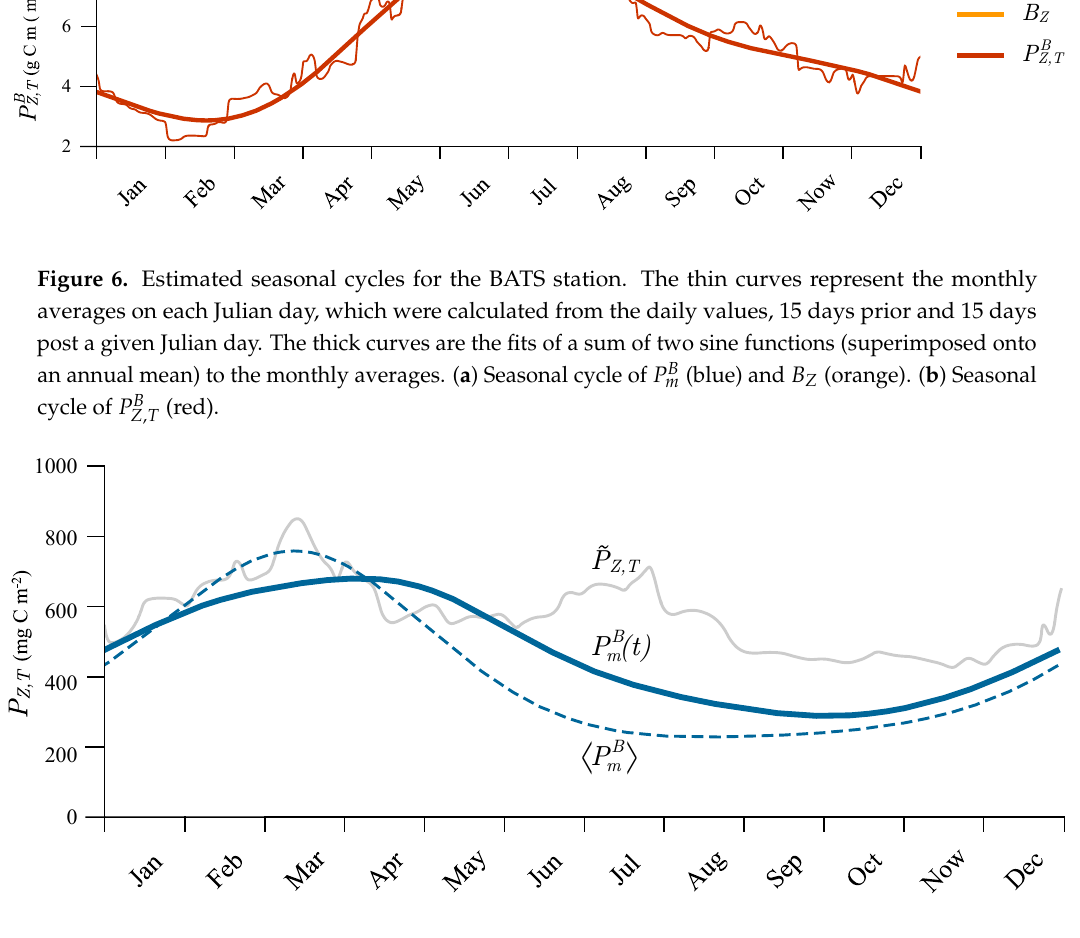
Figure 7. Comparison of the measured (grey curve) versus the modelled seasonal cycle of watercolumn production based on remotely sensed-chlorophyll with the time-dependent assimilation number, P B m ( t ) (blue curve), and the average assimilation number, (cid:104) P B m (cid:105) (dashed blue